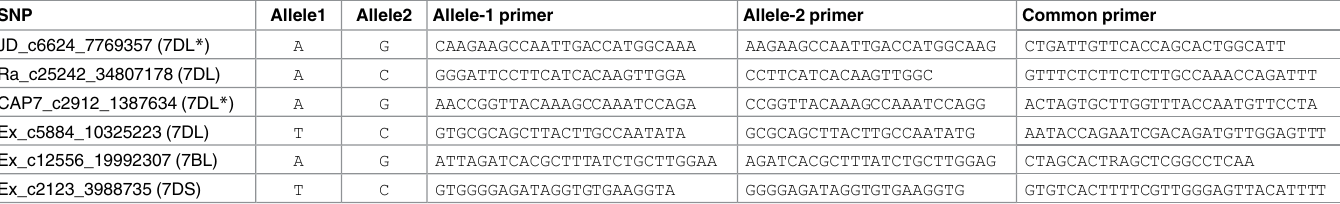
Table 1. Primer sequences of SNP markers for validation in wheat lines by KASP